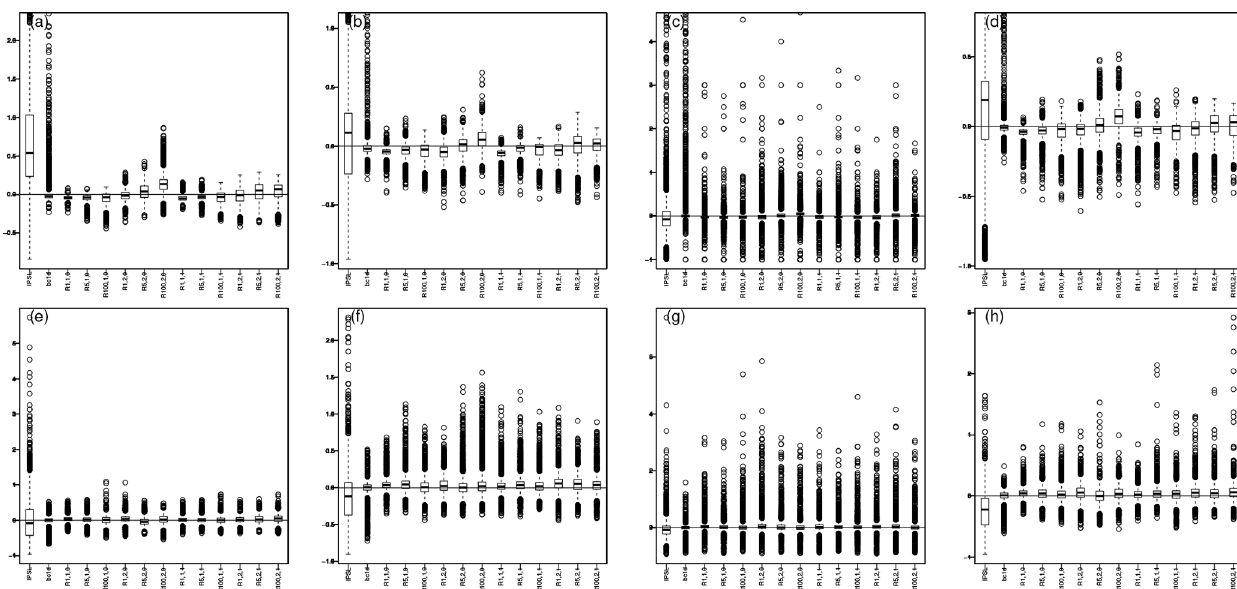
Figure 7. (a–d) Boxplots of relative differences of the probabilities of rainfall occurrence with respect to that of the reference data; (e–h) boxplots of relative differences of the mean conditional intensities given rainfall occurrences, with regard to that of the reference data. The results are given for winter (a, e) , spring (b, f) , summer (c, g) and fall (d, h) . To get rid of the drizzle effect, the threshold for precipitation occurrence is set to 0.1mmd − 1 . Associated maps are given in Figs. S21–S24 for occurrence probabilities and Figs. S25–S28 for mean conditional